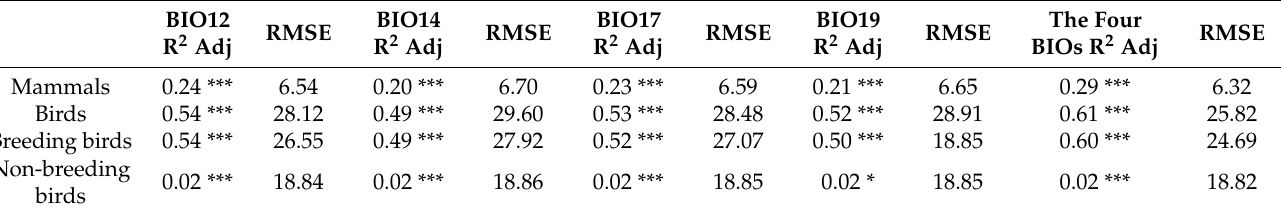
Figure 6. The relative importance of the three FPAR-based DHIs to the four main taxa.